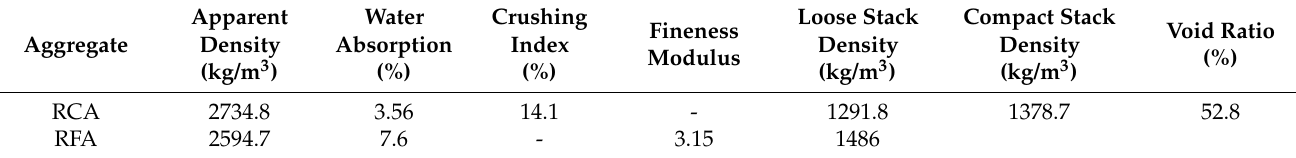
Table 4. Properties of RCA and